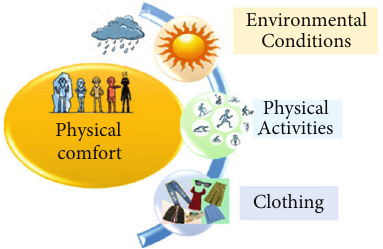
Figure 1: Factors a ff ecting physical comfort.